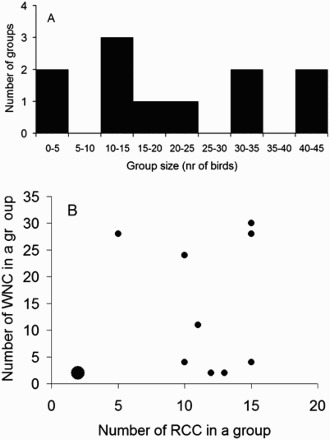
Group size distribution among the two-species flocks of cranes used in this study (a) and relationship between the number of Red-crowned cranes (RCC) and the White-naped cranes (WNC) in a group (b). The larger diameter circle in b indicates that two groups had the same values.